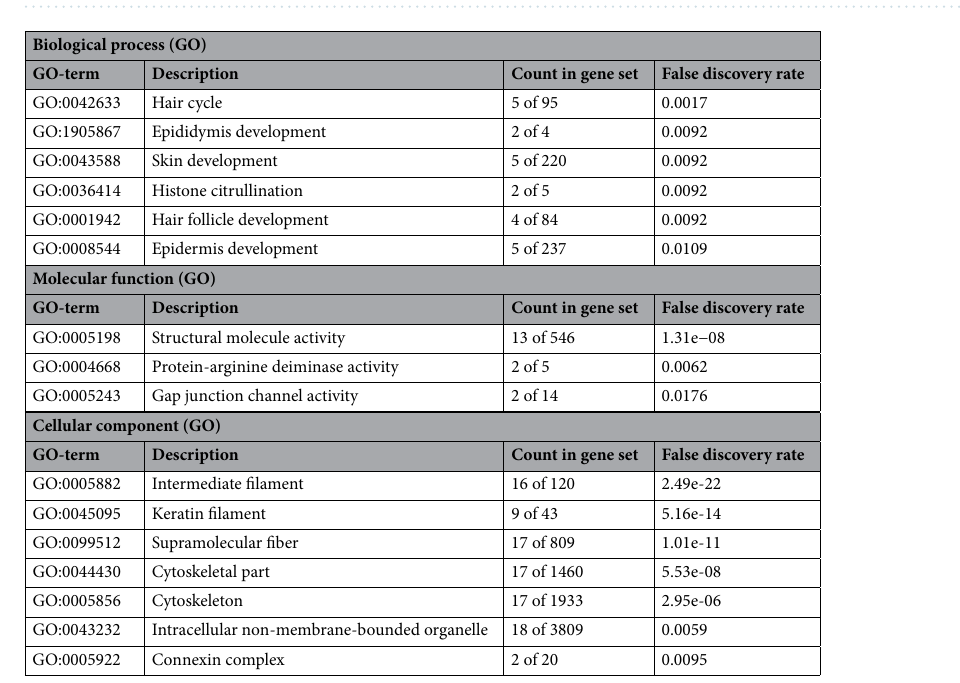
Figure 5. Representation of potential mRNA regulations by the 3 miRNAs identified after PBS irradiation (CYTOSCAPE analysis). Red rectangles represent the 3 miRNAs potentially involved in mRNA regulation.